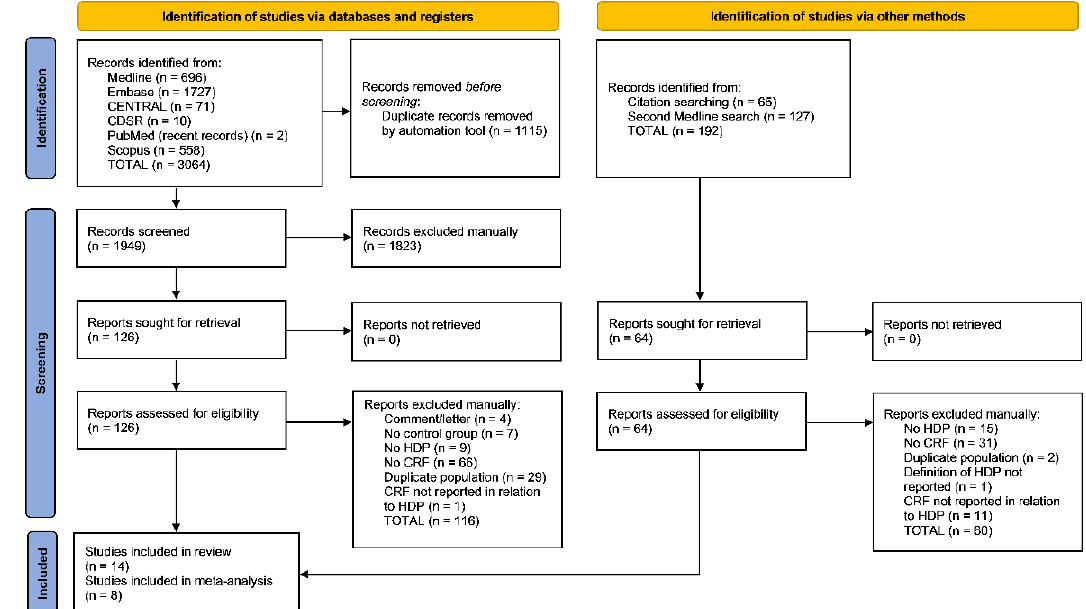
Figure 1. PRISMA flow diagram.